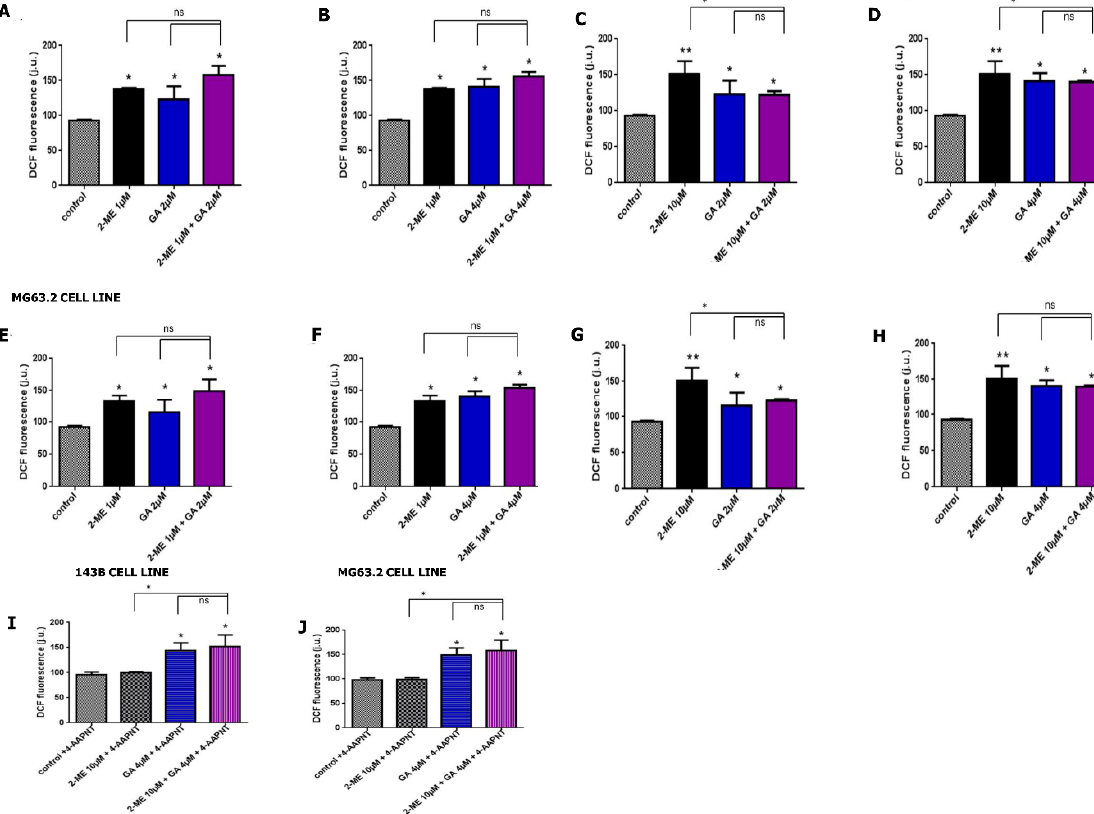
Figure 5. The total pool of nitro-oxidative stress in 143B ( A – E ) and MG63.2 cells ( F – J ) treated with either with 2-ME or GA, or a combination of both compounds. OS 143B cells ( A – D , I ) and MG63.2 ( E – H , J ) were treated for with vehiculum (Control) or either 2-ME (1 µ M or 10 µ M) or GA (2 µ M or 4 µ M), or a combination of both for 8 h. ( I , J ) present the data additionally using the pre-treatment with specific nNOS inhibitor (10 µ M 4-AAPNT) in OS 143B ( I ) and MG63.2 ( J ) cells. The total pool of nitro-oxidative stress was evaluated using 2 ′ ,7 ′ –dichlorofluorescin diacetate (DCF-DA) staining by means of flow cytometry. Data are presented as the mean ± SE values form at least three independent experiments. The absence of error bar denotes a line thickness greater than the error. Data were analyzed by GraphPad Prism Software version 6.02 performing one way ANOVA analyses followed by Tukey’s multiple comparison test. * p < 0.01, ** p < 0.001 versus control.